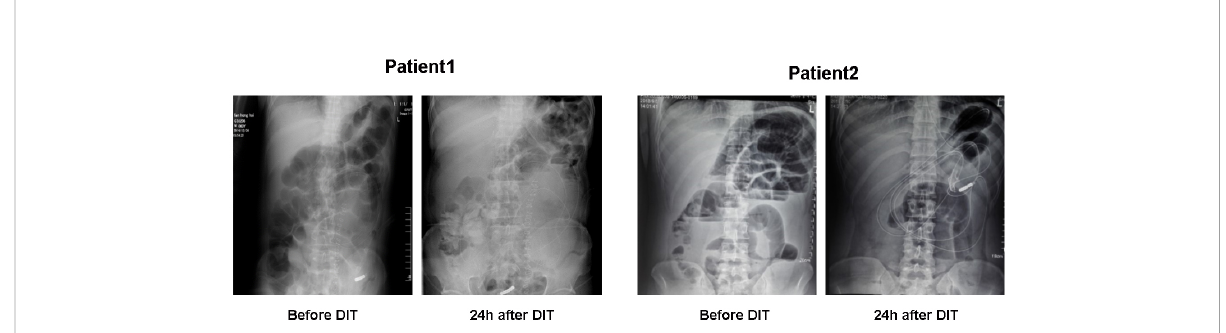
FIGURE 1 Presentative abdominal X-ray plain fi lms of the patients with acute intestinal obstruction before or 24 h after the deeper intubation technique